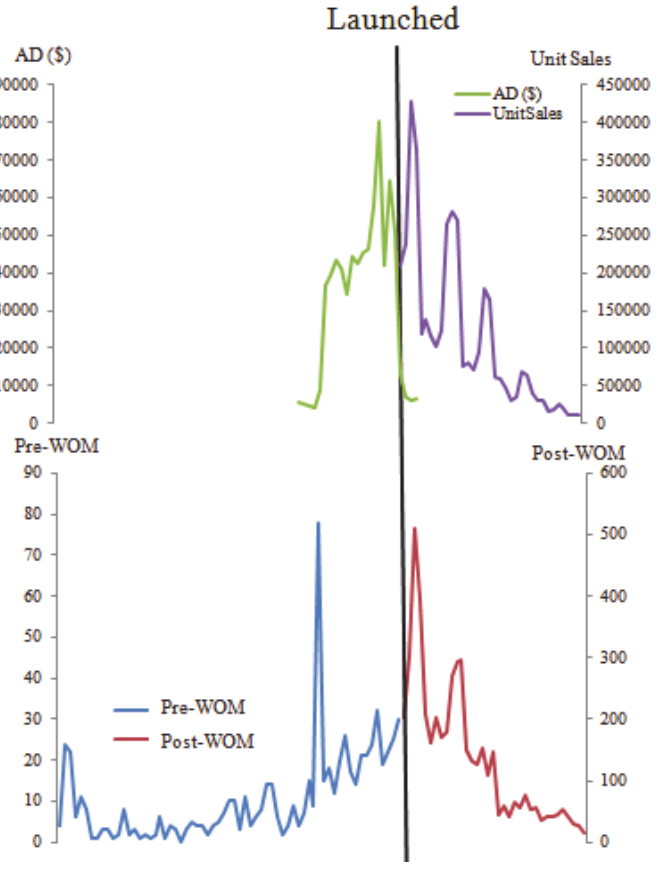
<Figure 2> Movie Demand, Advertising, and Word-of-Mouth for “Pirates of The Caribbean: Dead Man’s Chest” (Total unit sales: 3,932,502; advertising budget: $ 730,328; number of pre-launch WOM mentions: 756; number of post-launch WOM mentions: 7,438; running time: 35